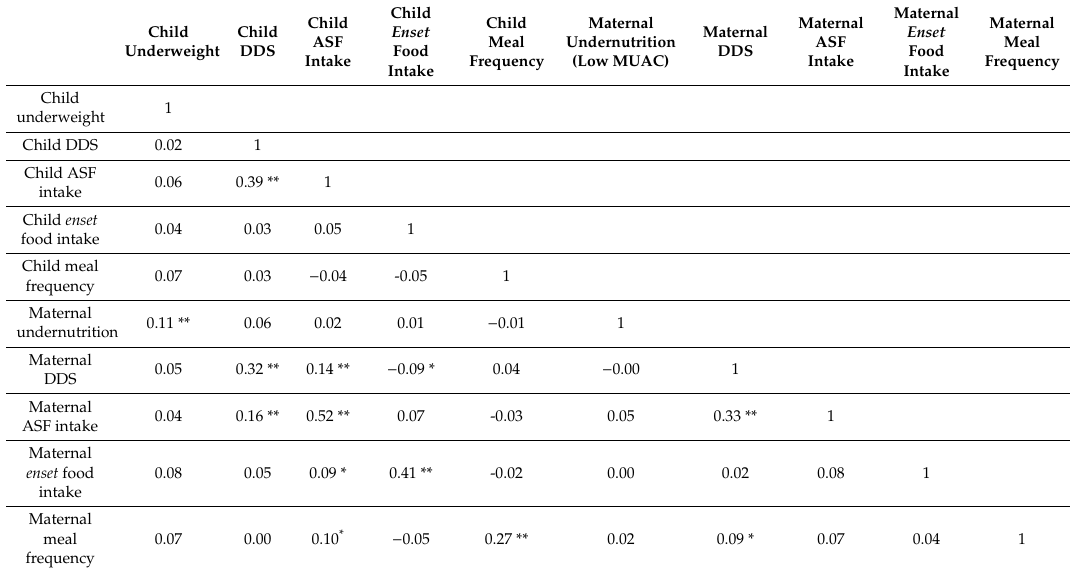
Table 5. Correlation of dietary diversity and anthropometric status of MCP (N = 578), January–June 2017. Child Child Underweight